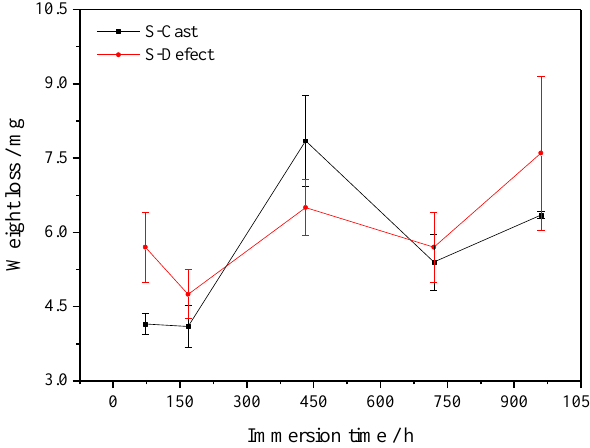
Figure 1. Weight loss of S-Cast and S-Defect immersed for different time periods in artificial seawater.